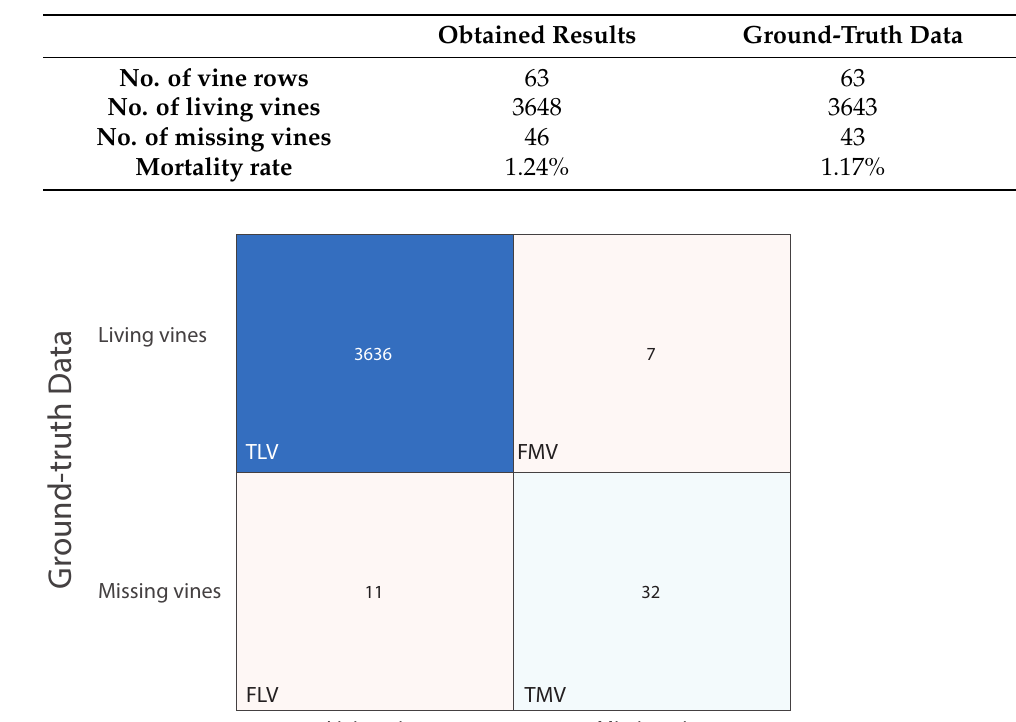
Table 2. Vine identification (Parcel 59B). Comparison between the obtained results and ground- truth data.